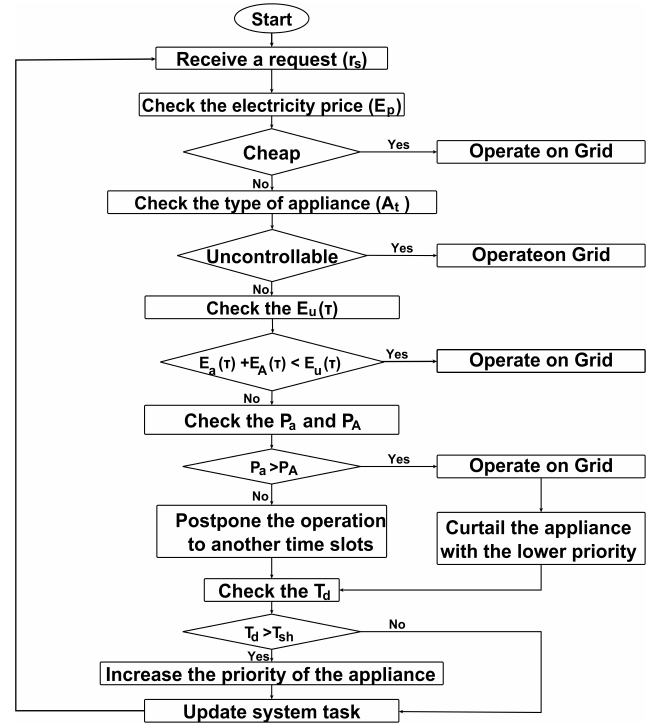
Figure 6. Structure of the proposed smart house and communication layout among different